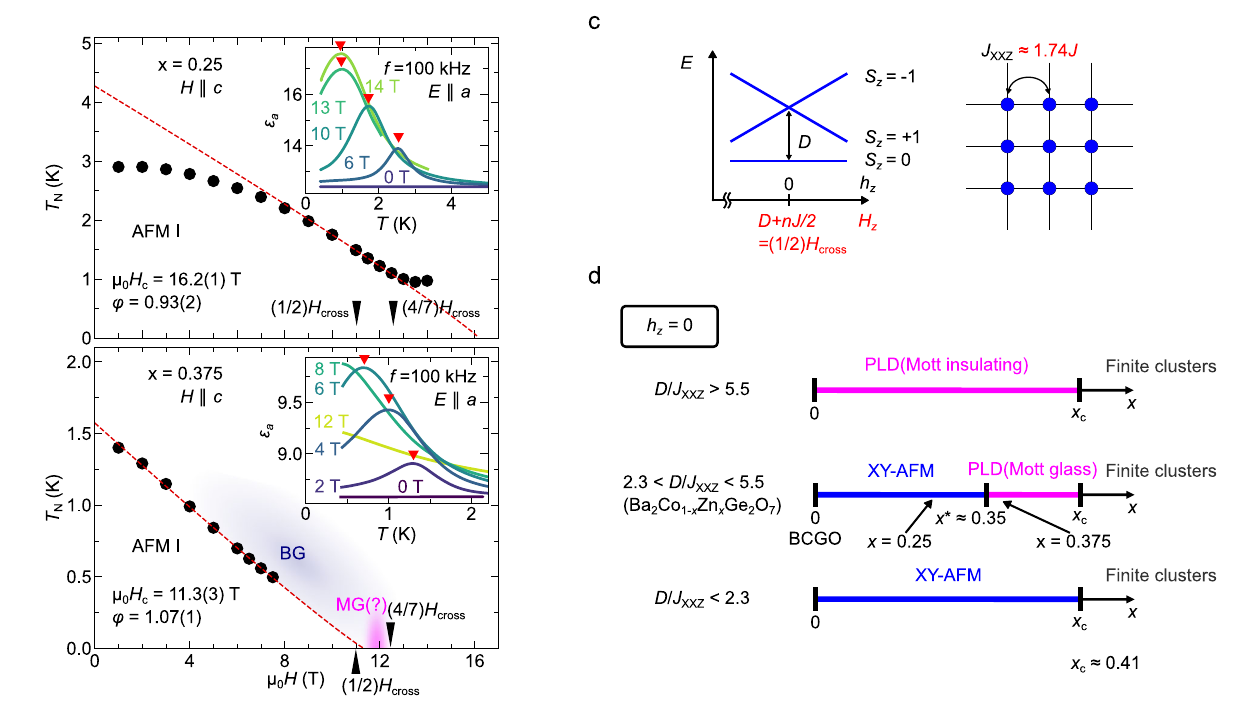
XXZmodelwithSIeasy-planeanisotropy D ^ S 2 z onasquare-lattice.Originalmultiplet, S z =3/2,1/2, − 1/2for S =3/2aremappedonto S =1, S z =1,0, − 1states[seeFig 1aand text].Magnetic fi eld h z and magneticinteraction J XXZ in S =1modelcorrespondsto D + nJ /2 and 1.74 J in original S =3/2 model, respectively. d Ground state magnetic phasediagram asafunction of x fordiluted S =1XXZ modelat h z =0.Line foreach D / J XXZ is reproduced from Fig. 1 in ref. 40 . x * ≈ 0.35isthe critical value for D / J XXZ ≈ 3, which corresponds to